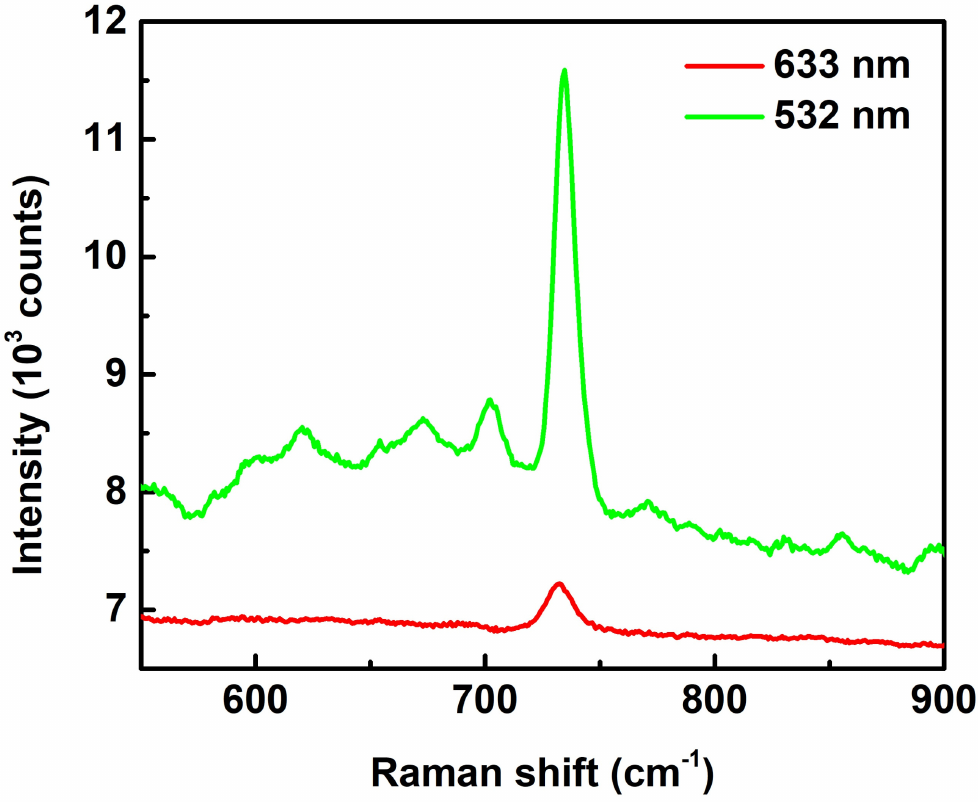
Figure 4. SERS spectra of adenine (concentration of 10 − 4 M) with excitation laser wavelengths of 633 and 532 nm. The spectra are pristine with neither intensity shift nor background subtraction. The objective lens of 50 × and exposure times of 3 s were used for the measurements. It is reasonable to assume that the SERS enhancement power of substrates is highly dependent on their silver morphology, which is dominated by the Ag-growth condition.